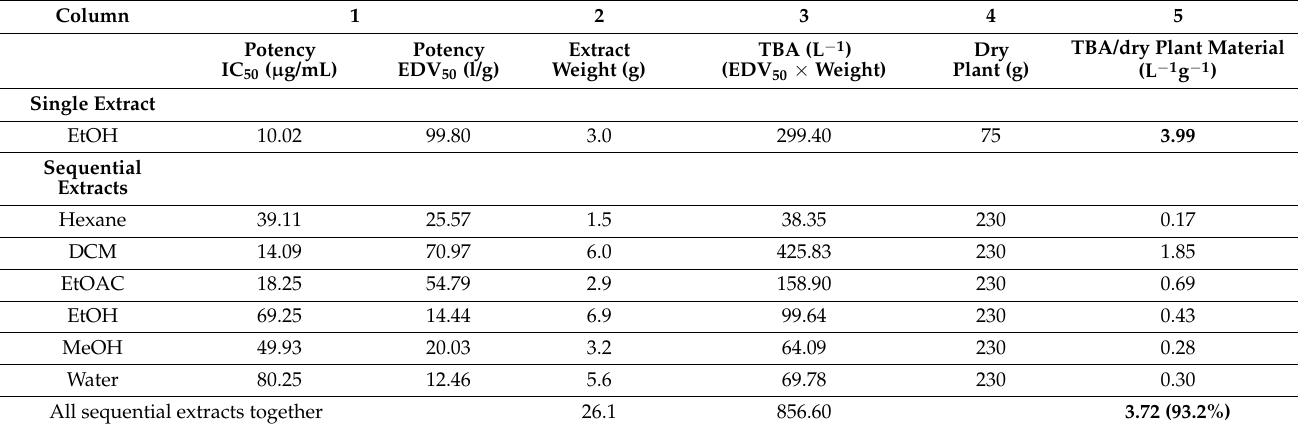
Table 2. Calculations for the TBA for solvent extracts.